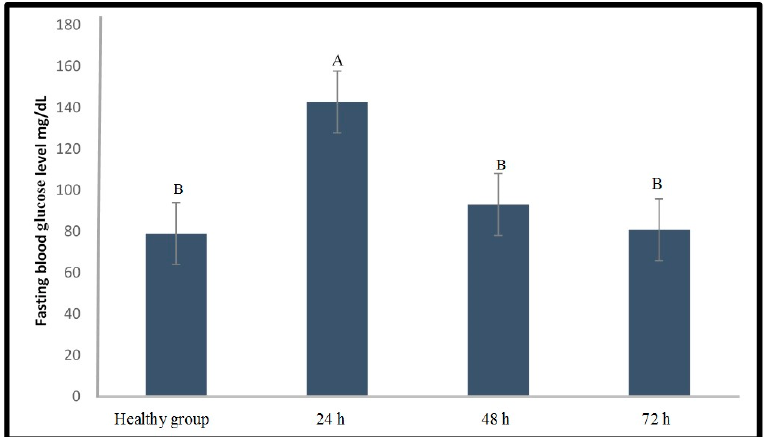
Figure 3. Fasting blood glucose level of zebrafish analyzed at different times after the injection of STZ (300 mg/kg). Different capital letter indicates significant difference ( p < 0.05) among the values, n = 10.